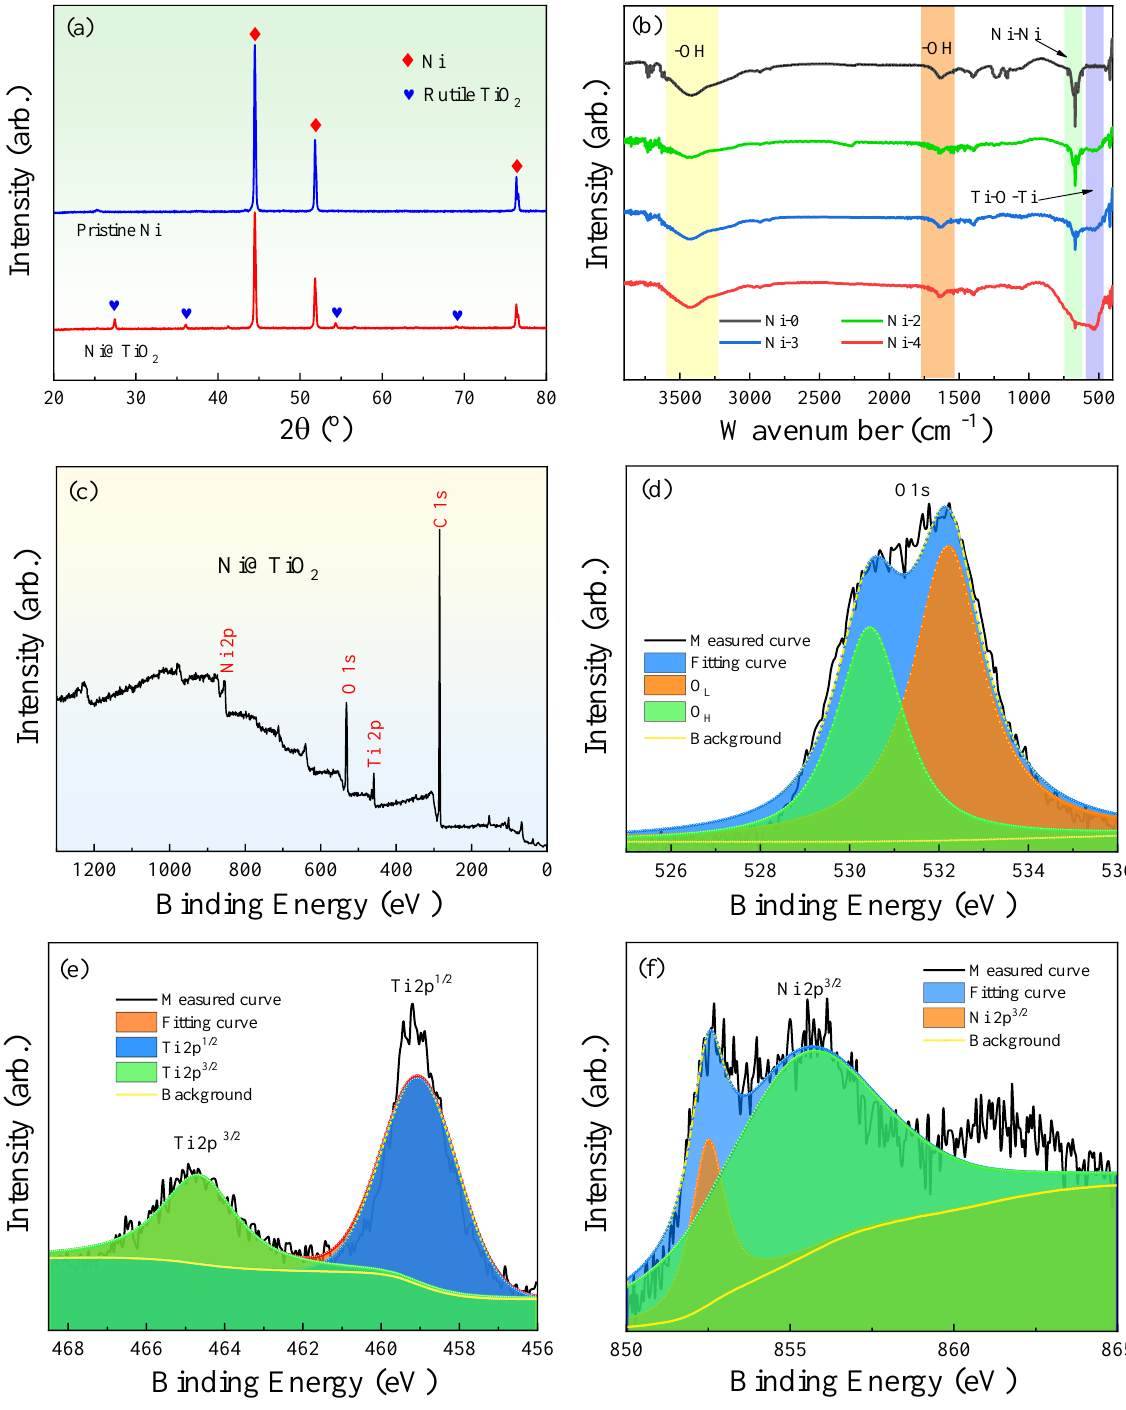
Figure 2. ( a ) XRD, ( b ) FT – IR, ( c – f ) XPS curves of Ni – 0 and core@shell structured Ni@TiO 2 particles.